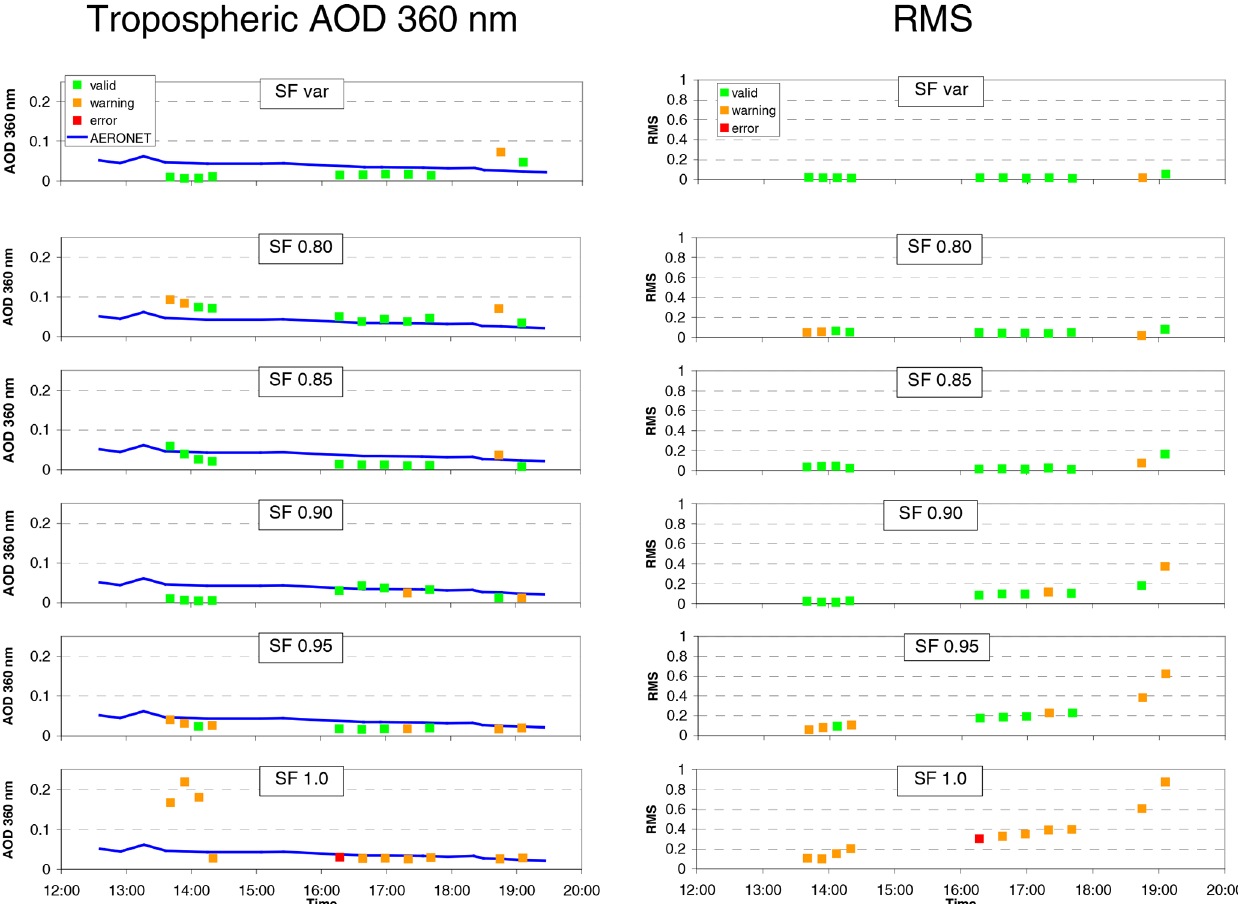
Figure A15. Left comparison of the retrieved AOD for the MAPA profile inversions with different scaling factors (squares) and the (tropo- spheric) AOD observed by the Sun photometer (blue lines). Right: rms between the measured and fitted O 4 dAMFs. The colours indicate the quality flags for the individual profile